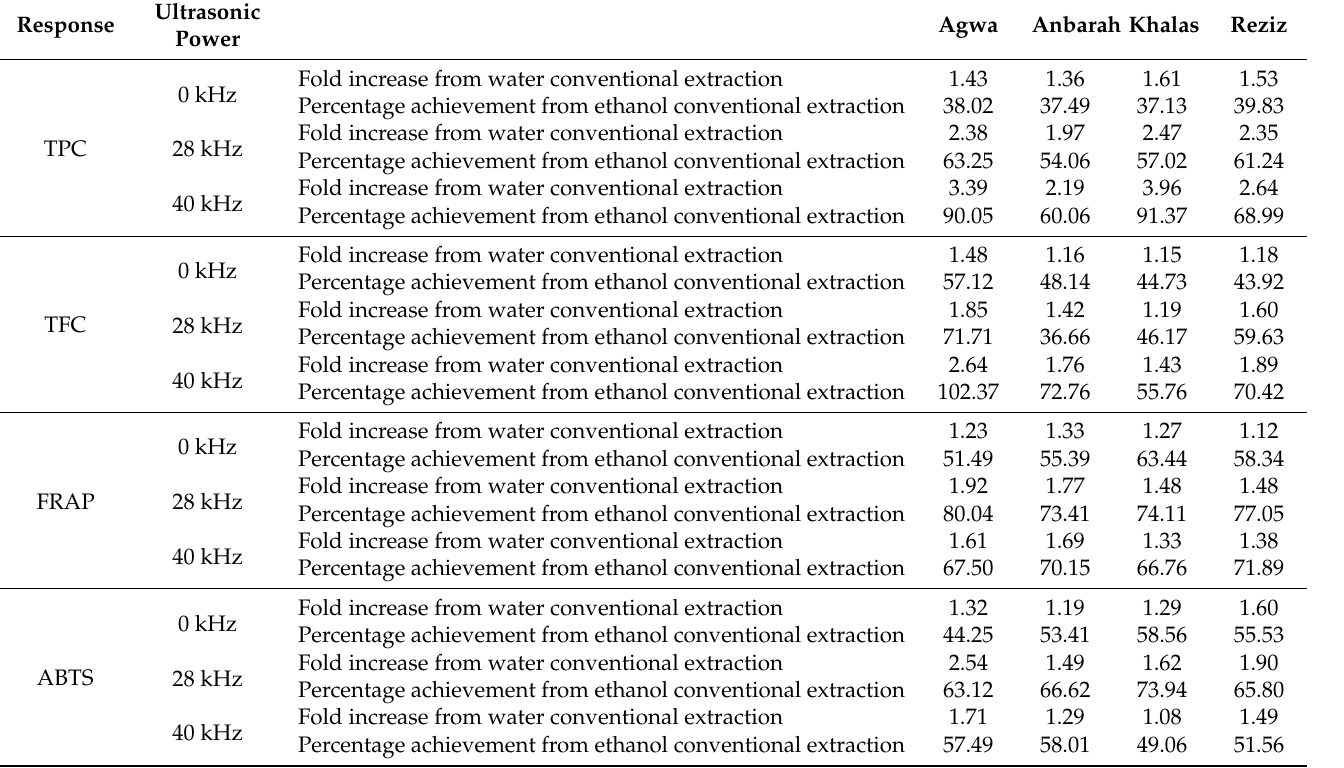
Table 4. Fold and percentage changes of the optimized UAE responses (TPC, TFC, FRAP, and ABTS) in relation to the conventical extraction methods (ethanol and water). This table is relating Tables 2 and